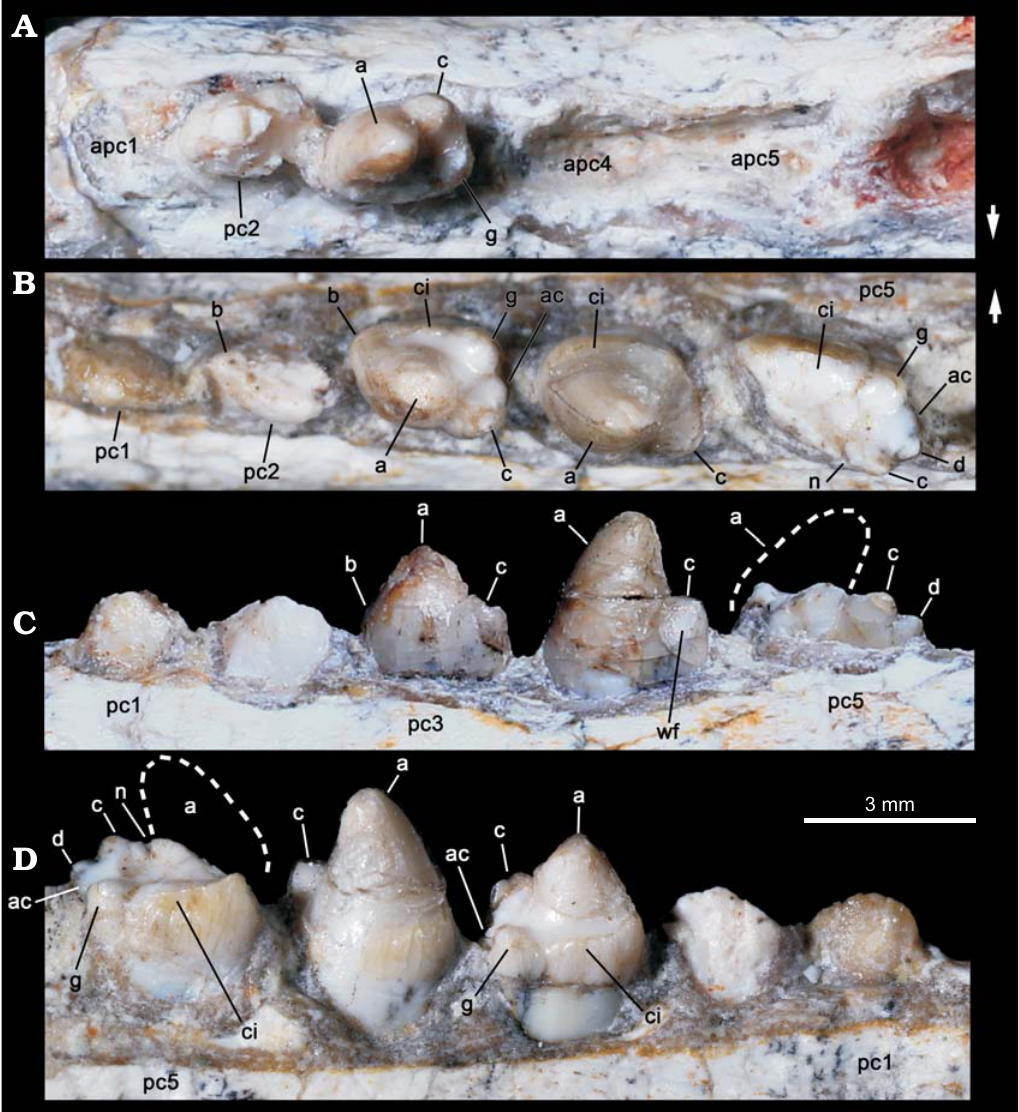
Fig. 4. Probainognathian eucynodont Candelariodon barberenai Oliveira, Schultz, Soares, and Rodrigues, 2011 (holotype, MMACR PV-0001-T) from the Middle–Late Triassic of Rio Grande do Sul state, Brazil. Detail of the lower postcanine dentition. Right tooth row in occlusal view ( A ) and left tooth row in occlusal ( B ), labial ( C ), and lingual ( D ) views. The dashed line represents the shape of cusp a. Arrows indicate lingual side. Abbreviations: a–g, cusps of the crown; ac, accessory cusp; apc, postcanine alveolus; ci, cingulum; n, notch between a/c cusps; wf, wear